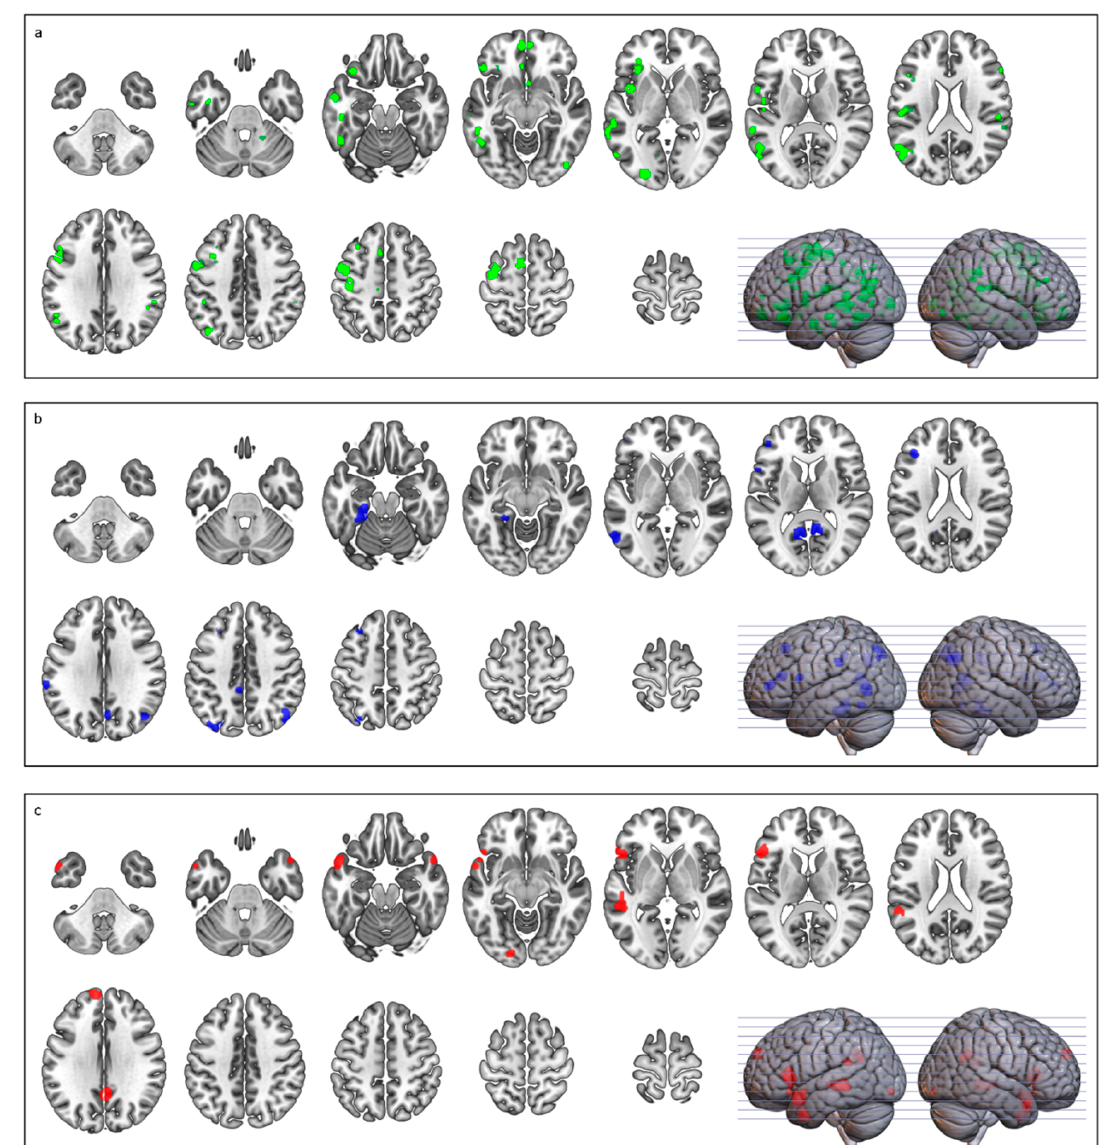
Figure 2. Brain activation related to ( a ) conjunction analysis (green); ( b ) concrete > abstract (blue); and ( c ) abstract > concrete (red). Images are in neurological display convention.